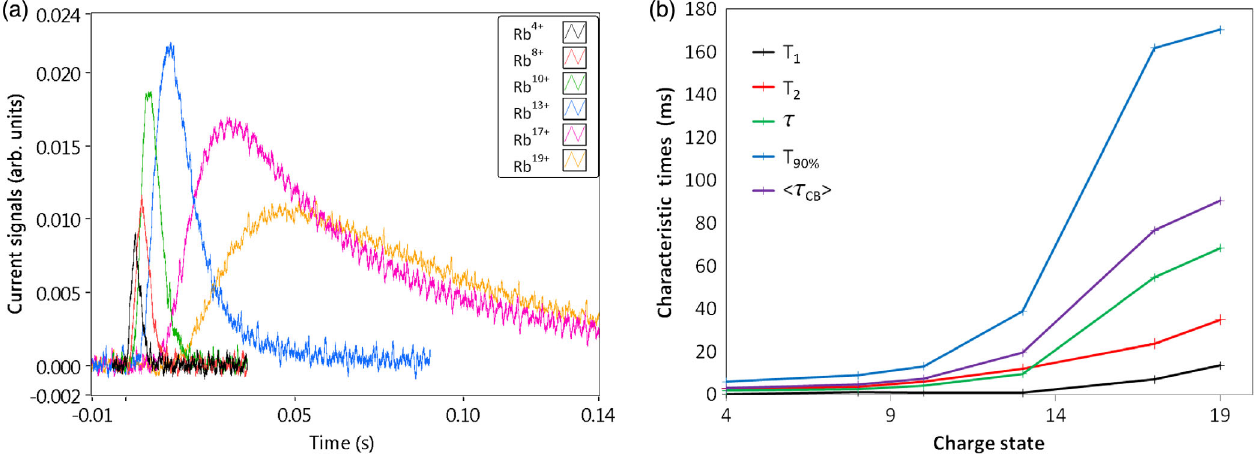
FIG. 6. (a) Rb 4 þ , Rb 8 þ , Rb 10 þ Rb 13 þ , Rb 17 þ , and Rb 19 þ beam intensities responses to a 2.5 ms pulse. (b) Evolution of the characteristic times as a function of the Rb charge state. The characteristic time parameters uncertainty is evaluated at (cid:2) 3 %.